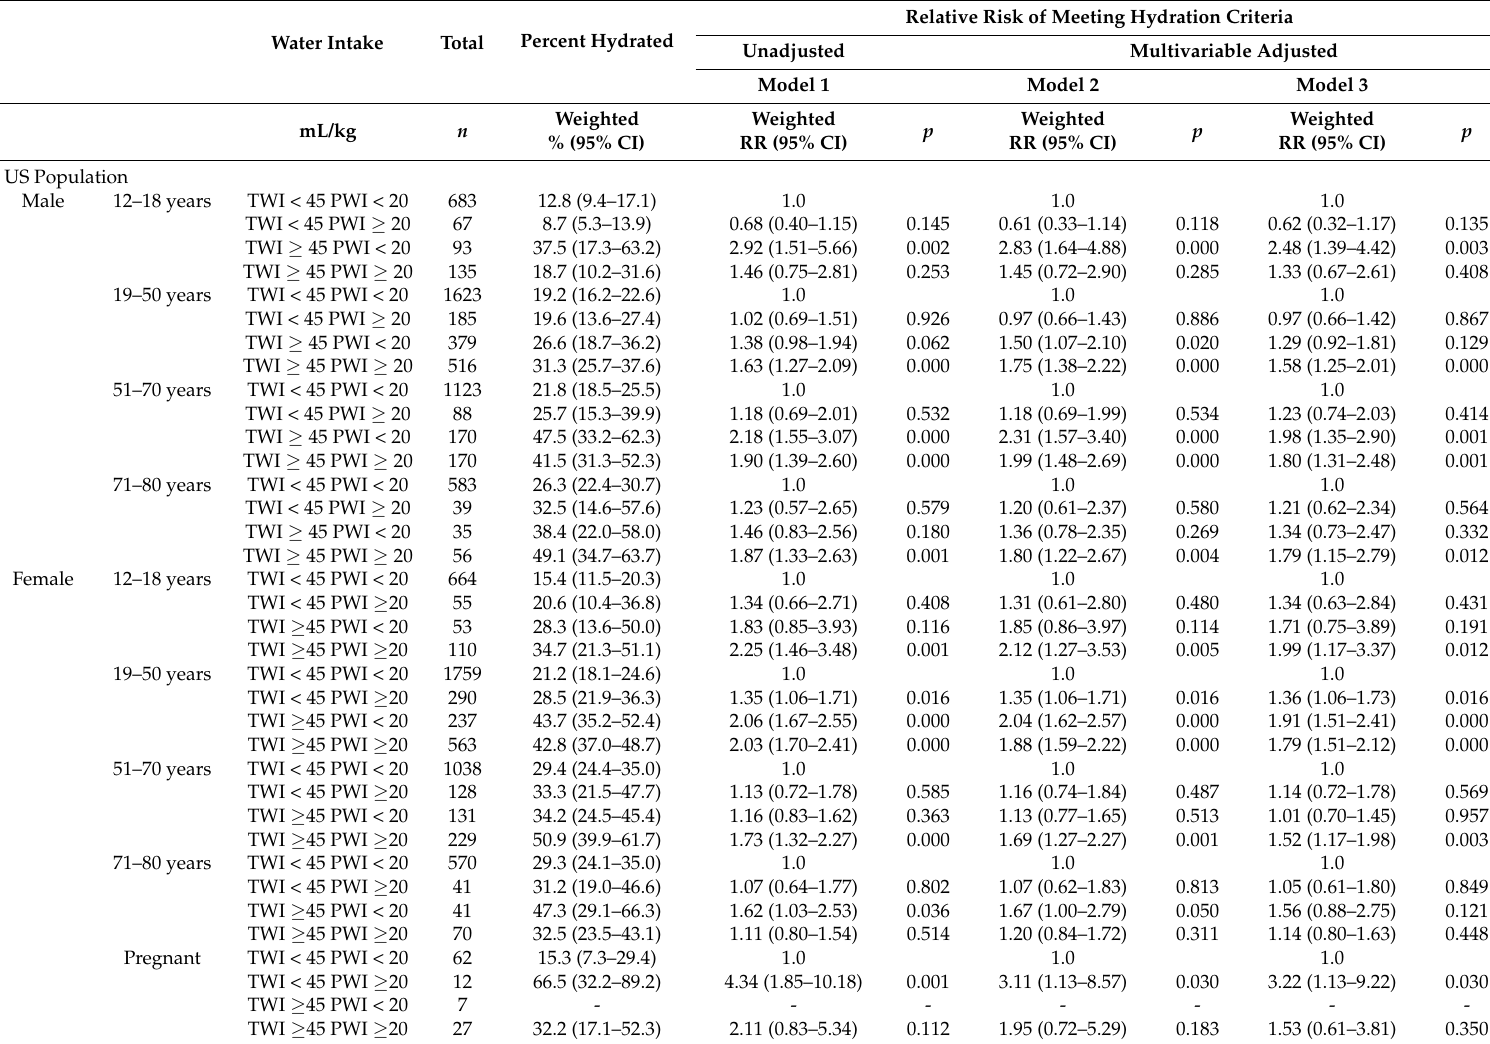
Table 5. Relative risk of meeting the hydration criteria associated with TWI ≥ 45 mL/kg and PWI ≥ 20 mL/kg for the US population aged 12–80 years in